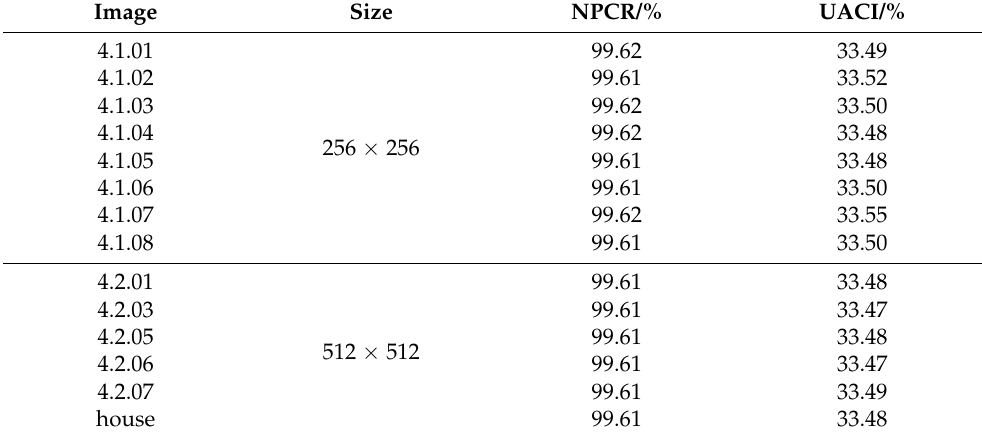
Table 6. NPCR and UACI test